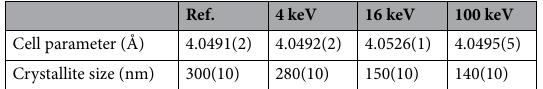
Table 2. Calculated parameters for Aluminum